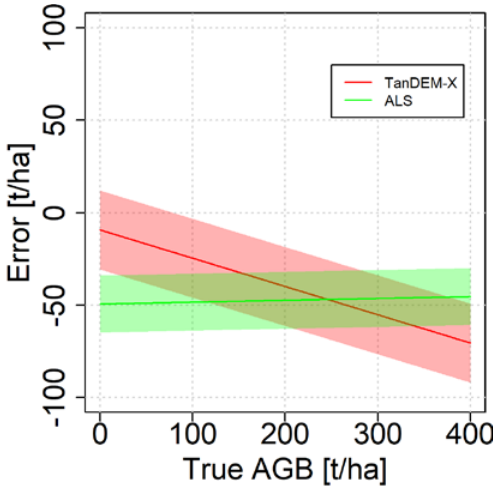
Figure 6. Visualization of the error structure for the empirical case study. The solid lines are due to λ ∗ and λ ∗ and the band width represents the random errors as ± 2 σ ∗ ε .